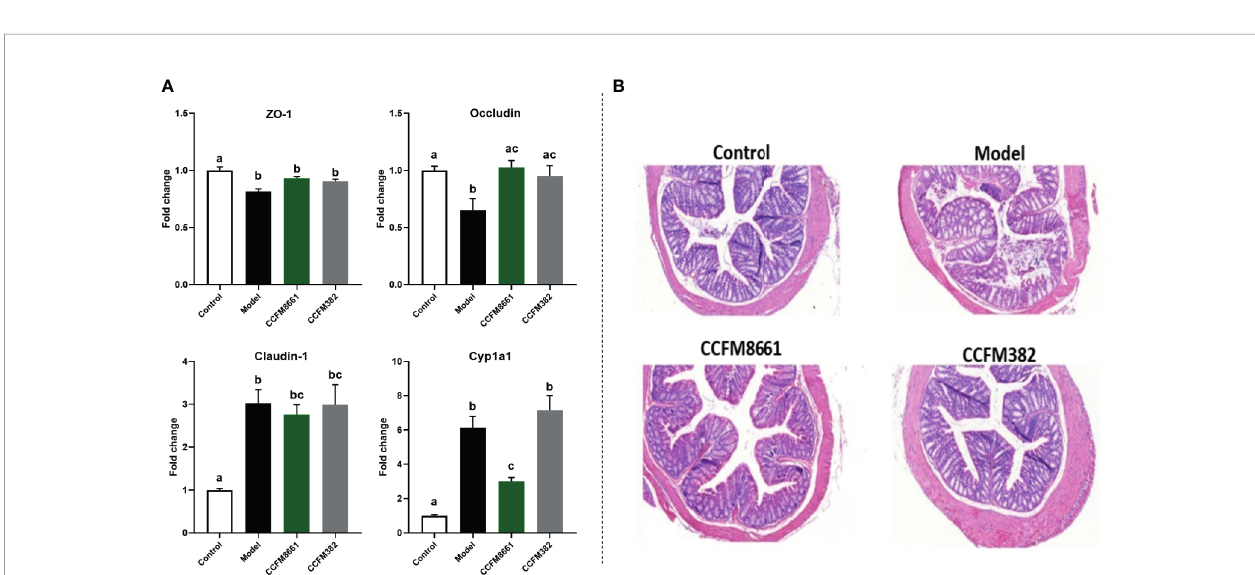
FIGURE 5 | Effect of L. plantarum CCFM8661 on the parameters related to the colon. (A) The mRNA expression of TJ proteins and CYP1A1. (B) Histopathological changes. The different letters indicate signi fi cant difference between groups ( P < 0.05